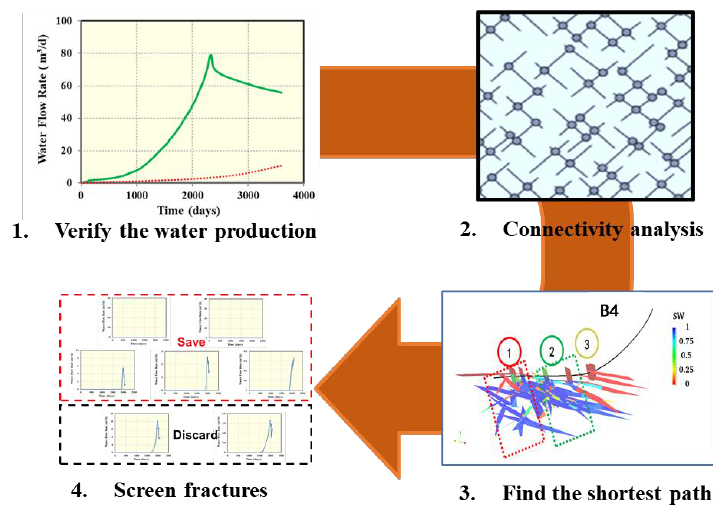
Figure 21. Workflow for water intrusion modeling applied in the well group model.